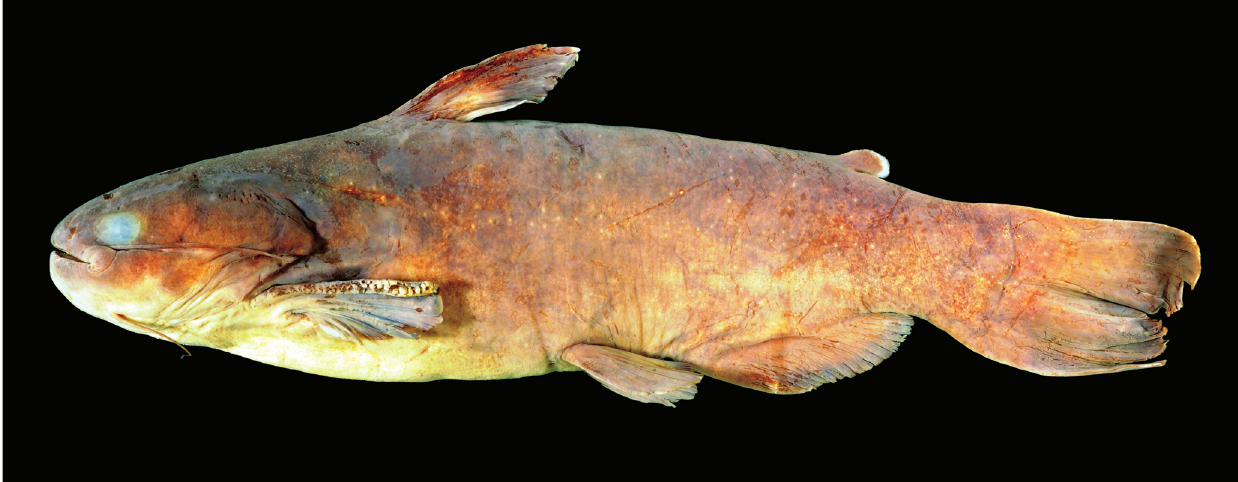
Fig. 1. Trachycorystes menezesi , new species, MZUSP 104671, holotype, 185.7 mm SL. Igarapé do Aeroporto, right bank tributary of rio Aripuanã, Aripuanã, Mato Grosso State, Brazil.